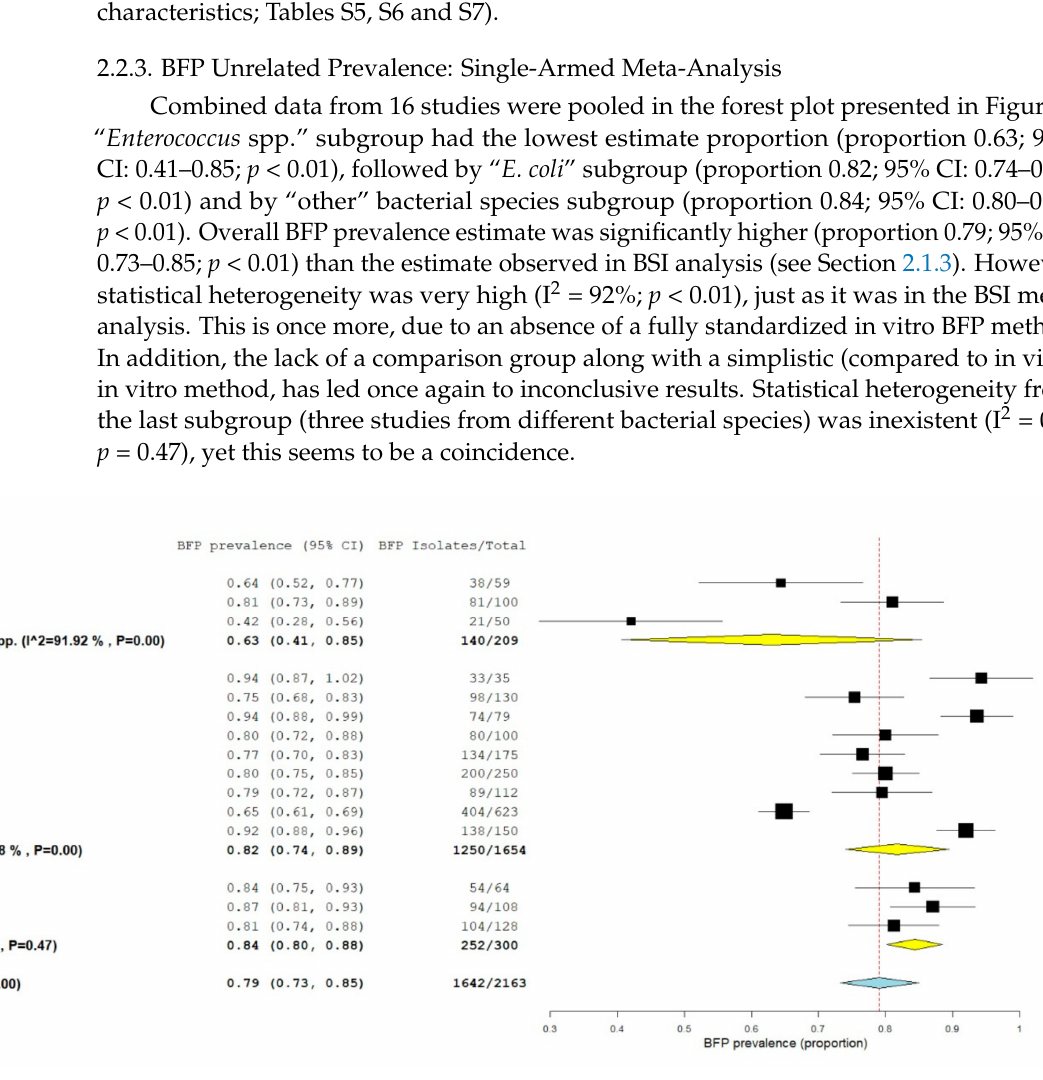
Figure 8. Forest plot of BFP (biofilm production) prevalence and subgroup analysis by microorganism—UTIs (Urinary Tract Infections). “P” represents the p -value. The “I 2 ” statistic describes the percentage of variation across studies that is due to heterogeneity rather than chance, where “CI” stands for confidence